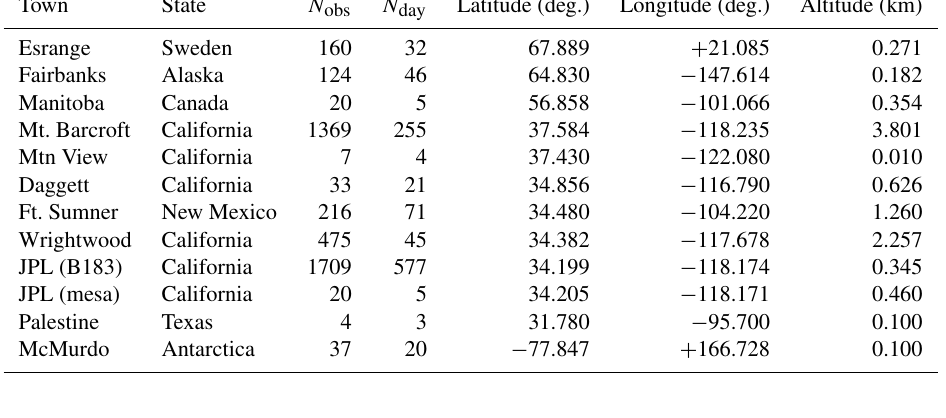
Table 3. MkIV ground-based observation sites, their locations and altitudes, and the number of observations and observation days from each site as of the end of 2016, sorted by latitude. N obs is the number of observations. N day is the number of observation days.